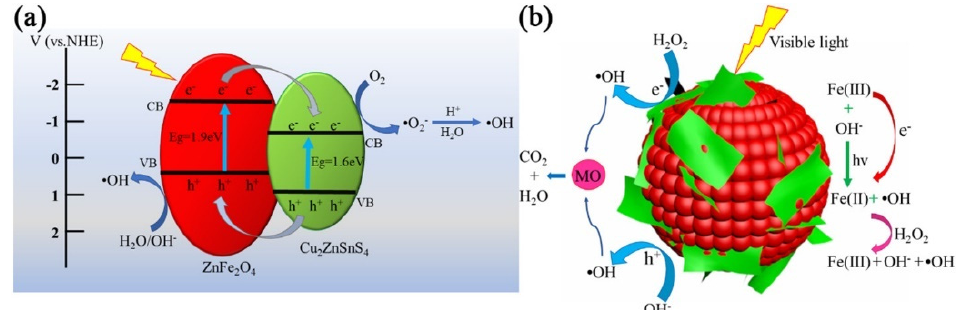
Figure 4. Schematic diagram for the photocatalytic degradation of MO by CZTS/ZFO p–n heterostructure plus H 2 O 2 : ( a ) the energy band structure, and the photo–induced carrier separation and transfer and ( b ) possible mechanism of photo–Fenton reaction in CZTS/ZFO + H 2 O 2 photocatalytic system. Reprinted with permission from Ref. [84]. Copyright 2020, Elsevier.